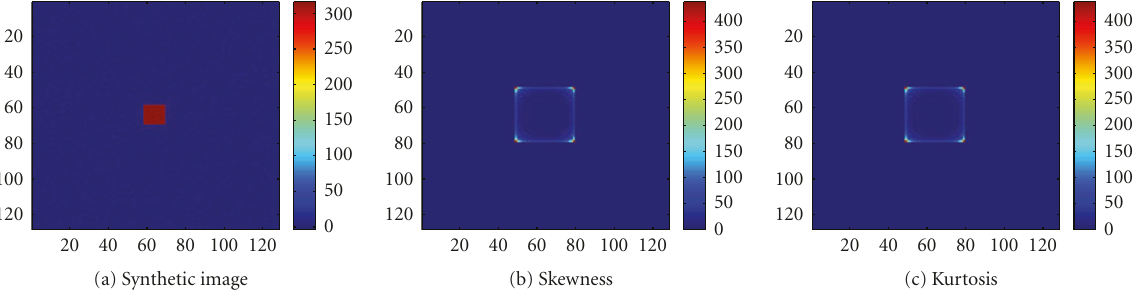
Figure 9: HOS evaluated on 21 × 21 windows (SNR = 50dB).